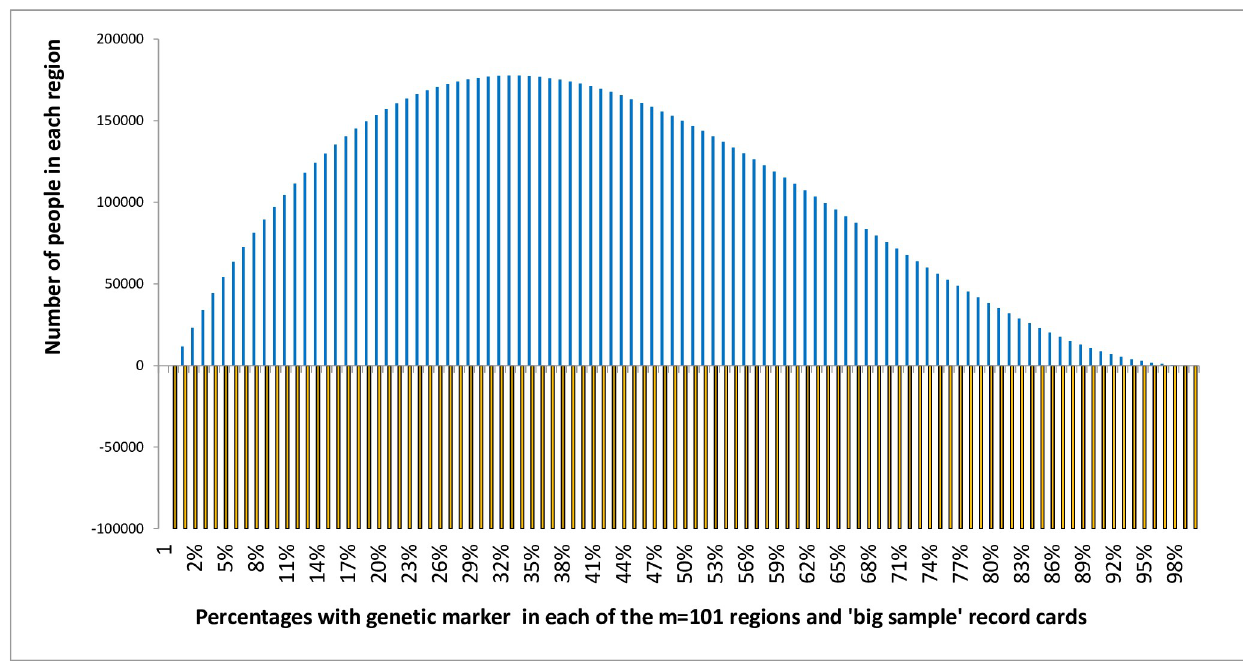
Fig 1. Number of people in each region (represented by the heights of the columns on the vertical axis) with each regional percentage possessing the genetic marker being represented on the horizontal axis and the equal number of random selection record cards represented by the rectangular distribution below the